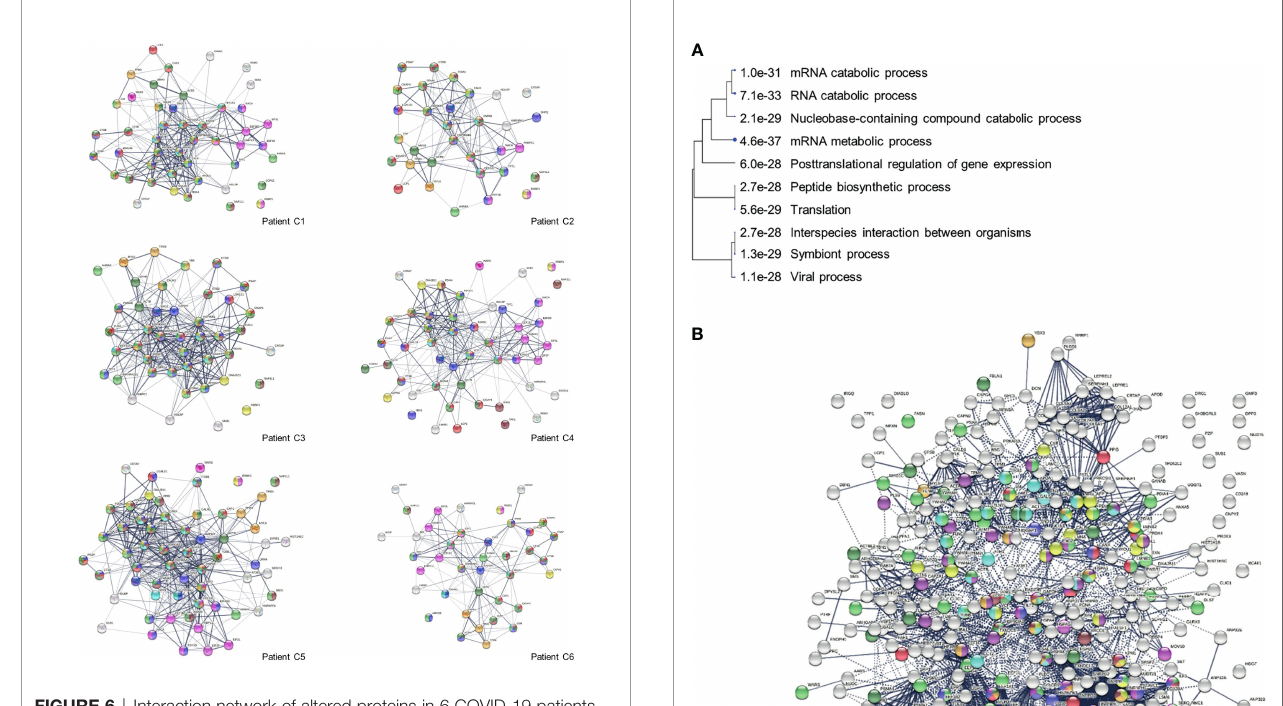
FIGURE 6 | Interaction network of altered proteins in 6 COVID-19 patients. Colored proteins are associated with leukocyte activation involved in immune response (red), vesicles (light green) and vesicle-mediated transport (dark green), protein processing in the ER (yellow), regulation of cell death (blue), translation (pink), melanosome (brown), myelin sheath (aqua), and muscle contraction (amber).